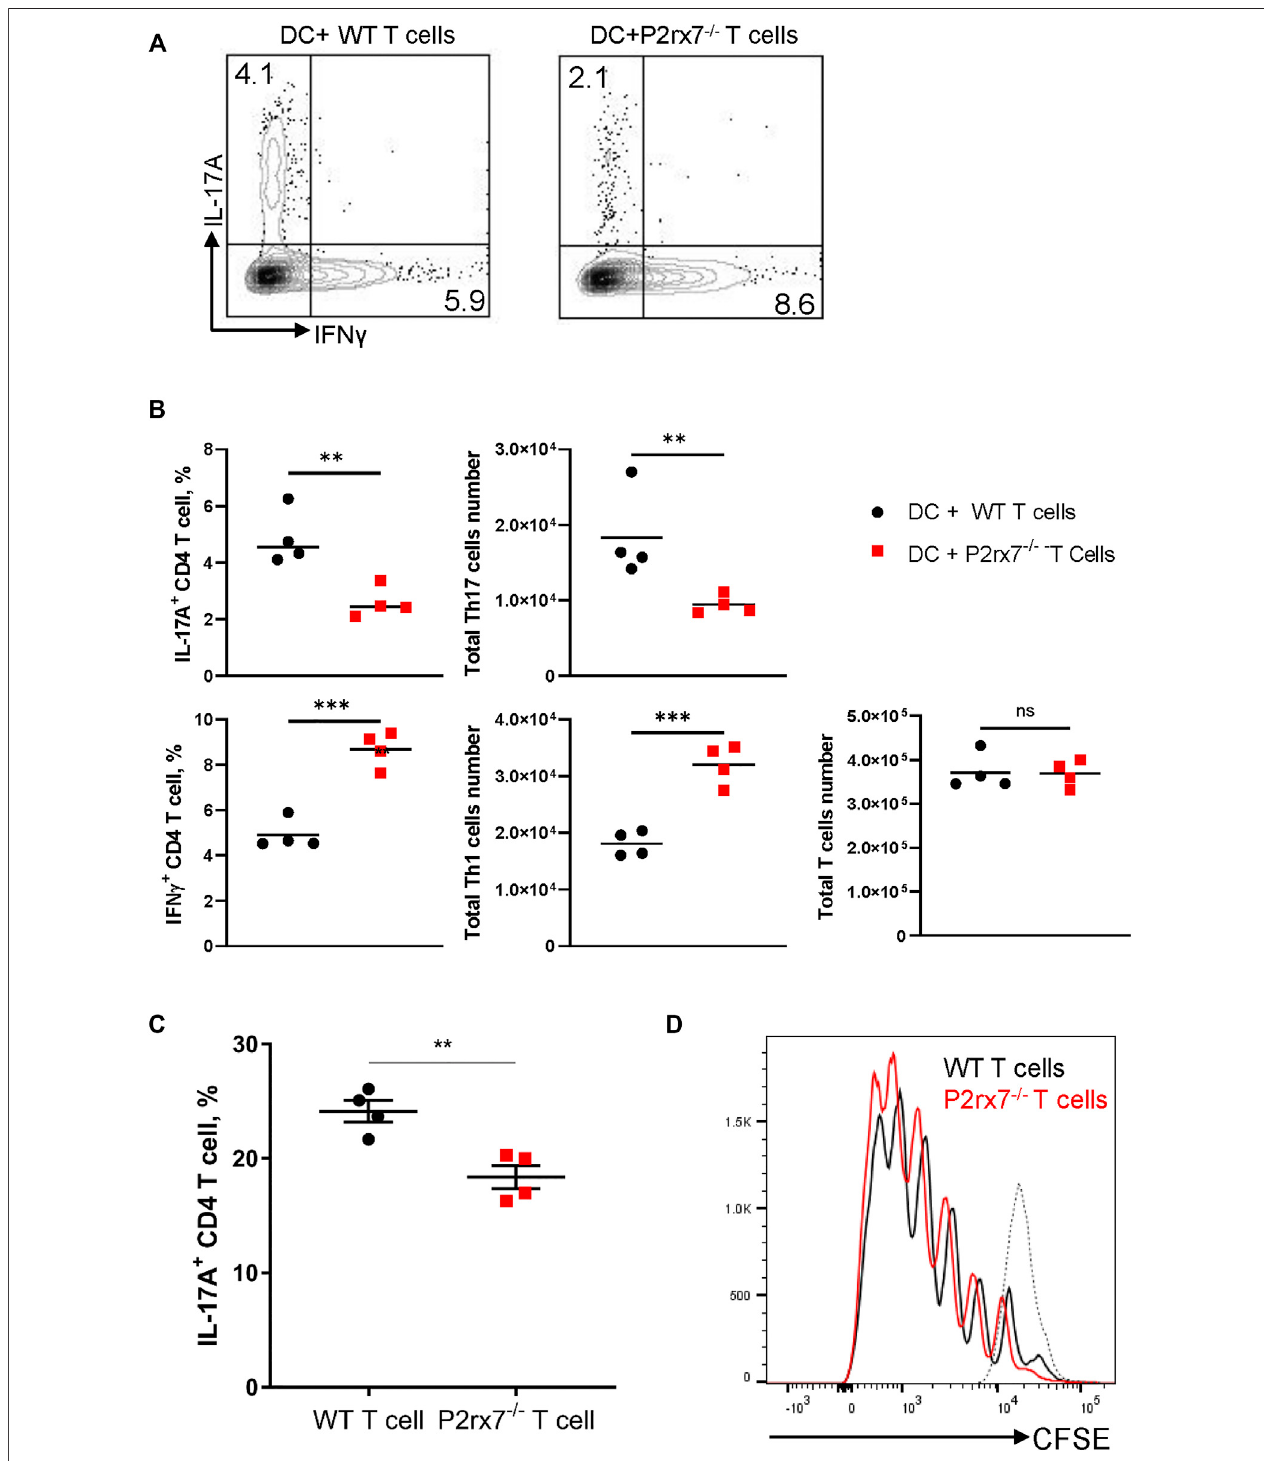
FIGURE 4 | Stimulation of P2X7R on CD4 + T cells enhances Th17 development in vitro . BMDCs and naive CD4 + T cells from either WT or P2rx7 − / − mice were cocultured in the presence of 0.2 μ g/ml anti-CD3, 100 ng/ml LPS, and 1 ng/ml TGF- β 1 for 4 days. Cells were harvested, restimulated, and stained. IL-17A + and IFN γ +CD4 + T cell percentages were analyzed by fl ow cytometry (A) Representative fl ow cytometric plots gated on CD3 + CD4 + T cells. (B) Percentage and total cell number of IL-17A + and IFN γ + CD4 + T cells were quantitated. (C) Naive CD4 + T cells isolated from WT or P2rx7 − / − mice were stimulated with plate-bound anti-CD3 (10 μ g/ml) and anti-CD28 (2 μ g/ml) in the presence of Th17-skewing cytokines for 4 days. Percentages of IL-17A + T cells were determined by fl ow cytometry following